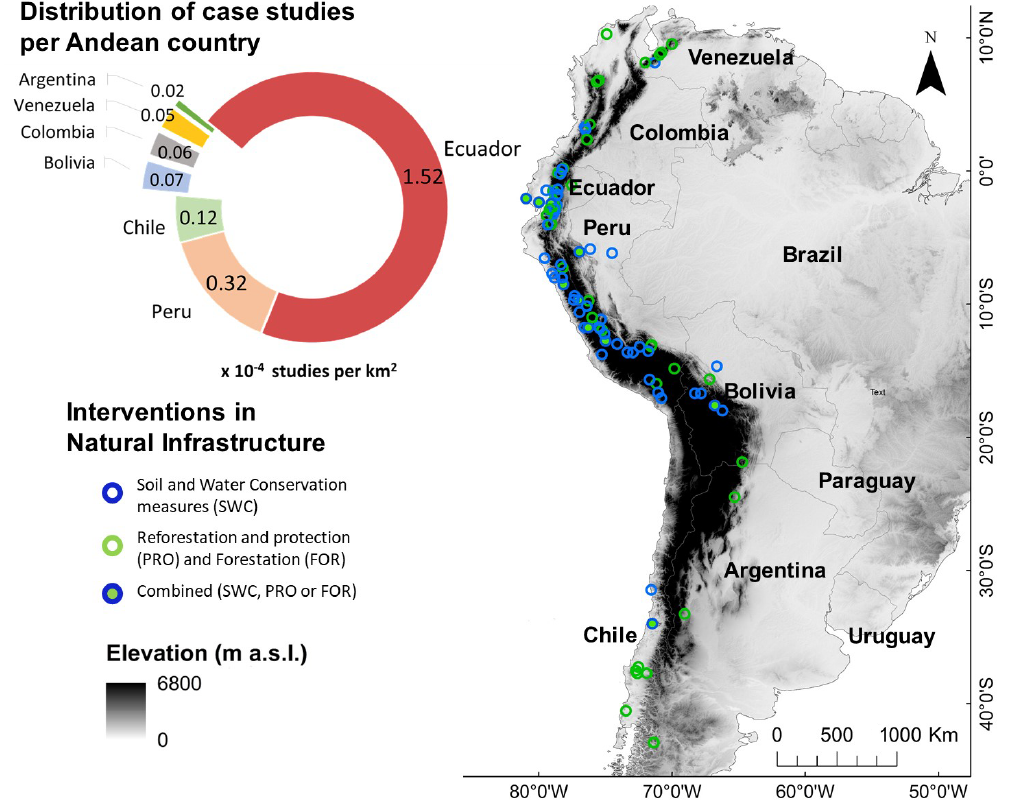
Figure 3. Spatial distribution of case studies in the Andean region, classified per type of natural infrastructure intervention. The background map corresponds to the 30arcsec DEM of South America (GTOPO30, U.S. Geological Survey’s Center for Earth Resources Observation and Science, EROS). m a.s.l. meters above sea level. Table 1. Summary of the mean indicator values per treatment, with indication of the number of individual case studies between brackets. The values are reported for three interventions in natural infrastructure. PRO is restoration and protection of natural vegetation like forest or native grasslands, FOR is forestation with native and/or exotic species, and SWC is implementation of soil and water conservation measures, and for three untreated areas: CROP (cropland), RANGE (rangeland under traditional agricultural management), and BARE (bare land corresponding to abandoned cropland or degraded land with very low ( < 10%) vegetation cover). Difference between groups was tested with the Kruskal–Wallis rank sum test, and p -values are estimated using the chi-squared